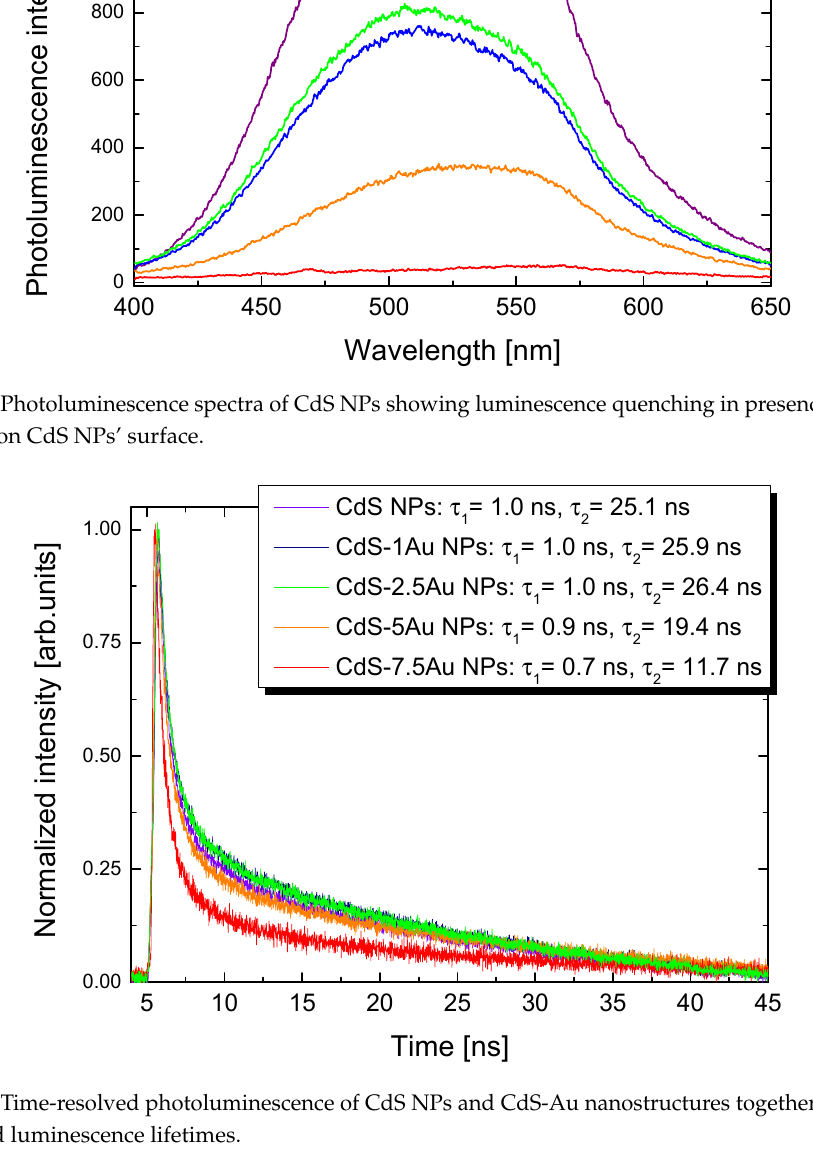
Figure 3. Time-resolved photoluminescence of CdS NPs and CdS-Au nanostructures together with the calculated luminescence lifetimes.